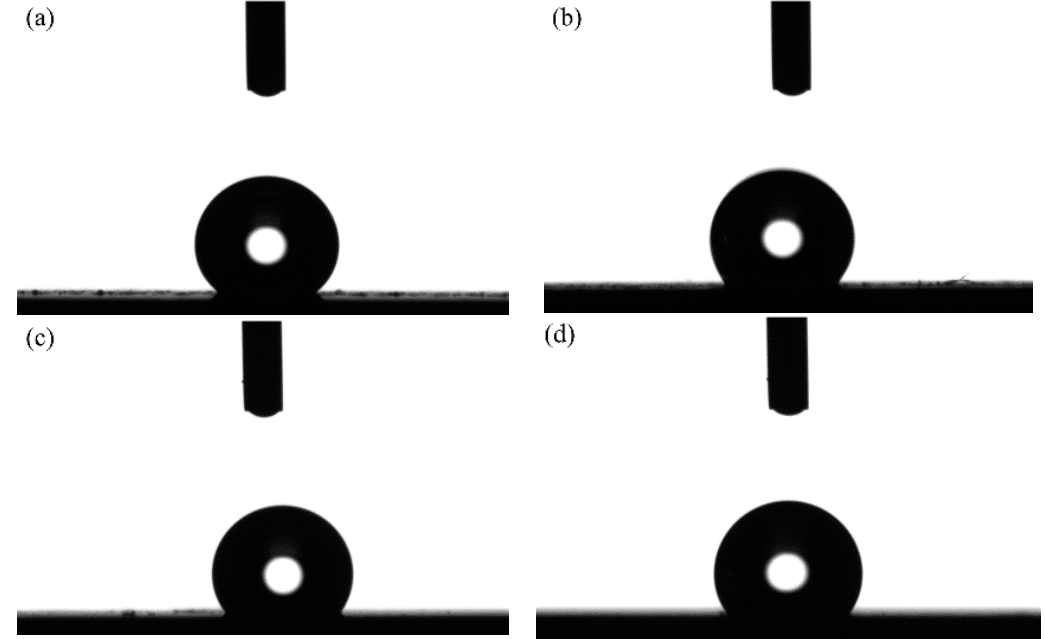
Figure 16. Optical profile of water drops of textured surface with varying spot-to-spot distance: ( a ) 150 µm; ( b ) 200 µm; ( c ) 250 µm; ( d ) 300 µm.